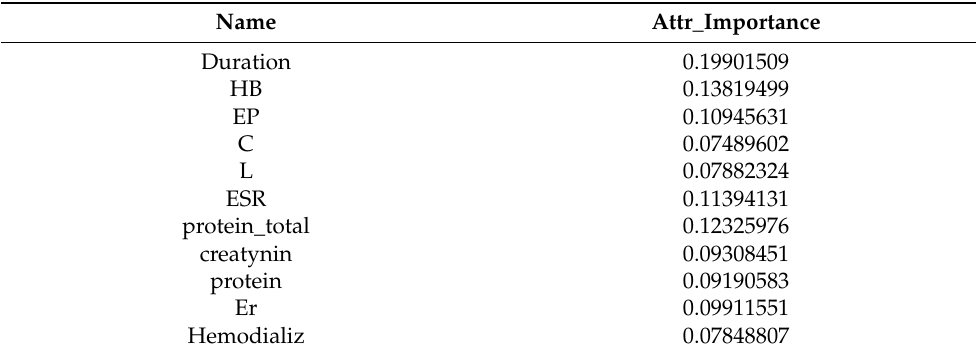
Table 2. The selected variables using information gain.